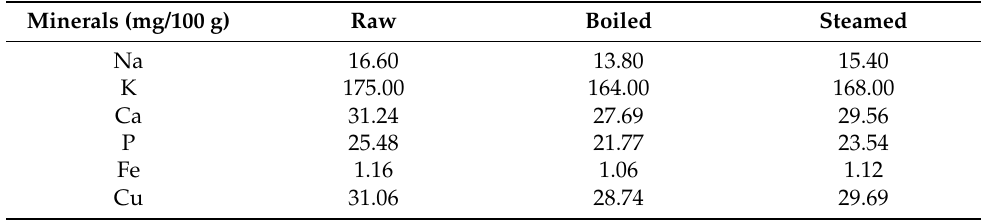
Table 4. Mineral composition of raw, boiled, and steamed eggplant ( Solanum macrocarpon ) leaves in mg/100 g